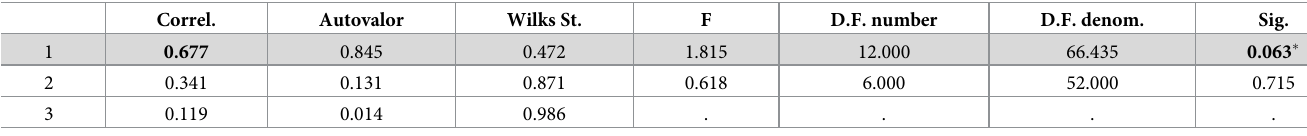
Table 11. Canonical correlations: Control group after the experiment. Correl. Autovalor Wilks